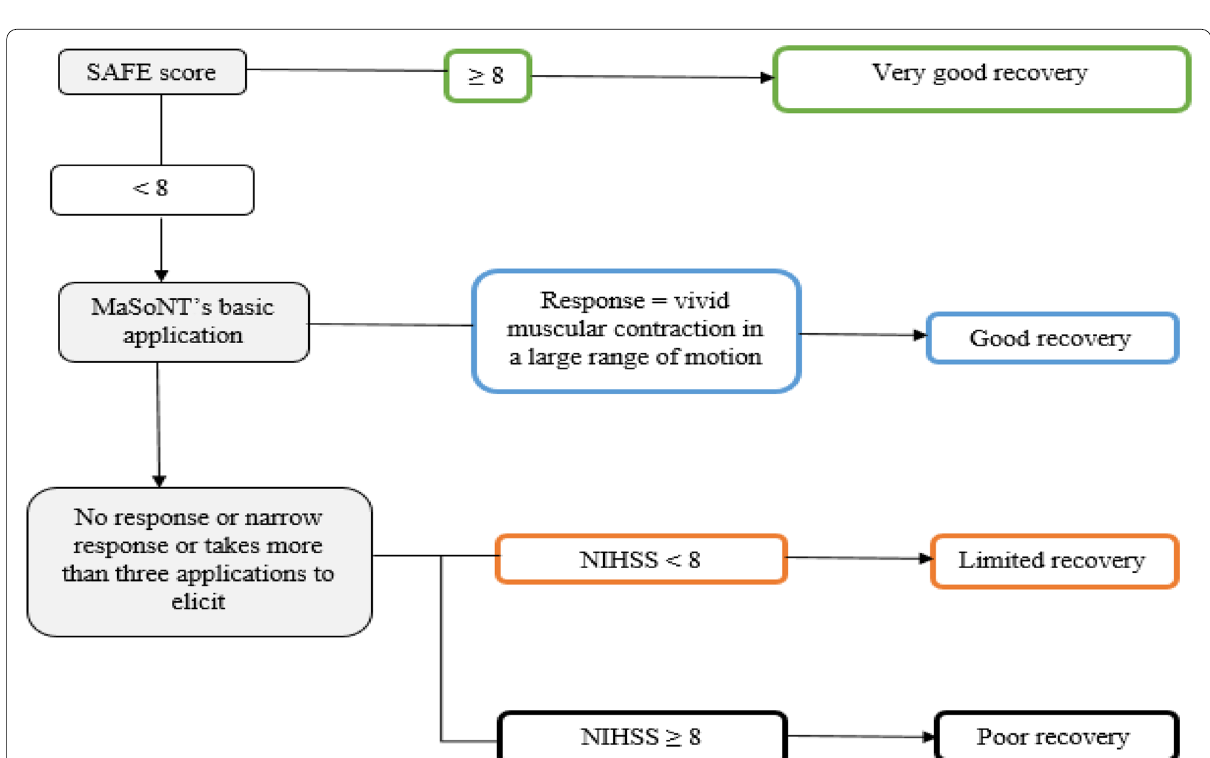
Fig. 5 The APRAHL algorithm for the hemiplegic upper-limb prognosis. SAFE, sum of the shoulder abduction and finger extension Medical Rating Council muscle grades at day 3 after stroke; MaSoNT, Mobilization and Stimulation of Neuromuscular Tissue; NIHSS, National Institutes of Health Stroke Scale. The test starts at day 3 after stroke. The patient is categorized according to the SAFE score to very good recovery if the score is above or equal to 8. If the SAFE score is lower than 8, the basic technique of MaSoNT is applied on the extensors’ muscle group of the upper limb at day 3. The therapist, then, assesses the elicited brisk muscular contraction which is triggered as a response to that stimulation. If the response is a vivid muscular contraction in a large range of motion, the prognosis is good. If there is no response or if the response is narrow or subtle or takes more than three applications to elicit, the prognosis is limited if the NIHSS is under 8 and poor if the NIHSS is over